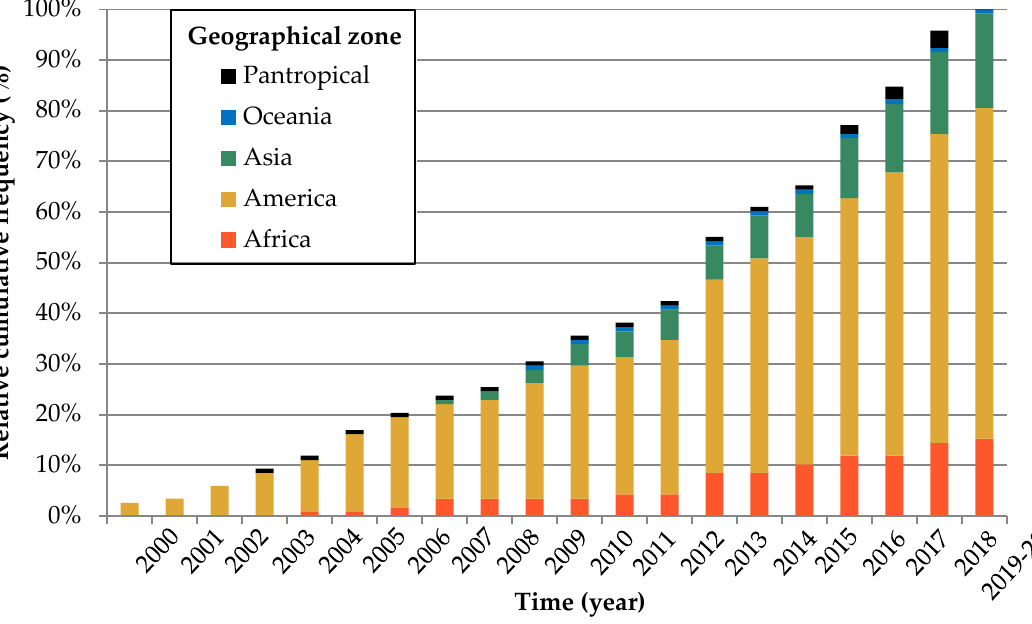
Figure 4. Relative cumulative frequency of articles according to time and to their geographical zone.